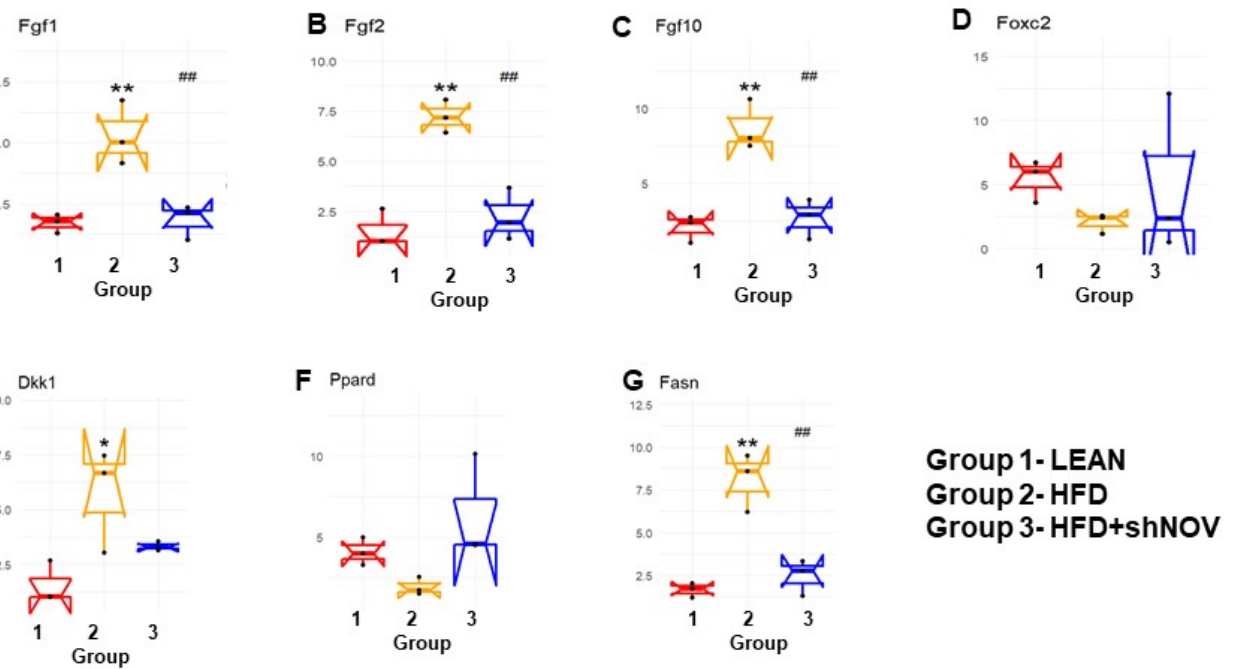
Figure 11. Changes in gene expression in the adipose tissue of shNOV-treated mice (NOV knock- down). RNA-array-analyses changes in the correlation coefficients of gene expression in lean, HFD, and Lnv-adipo-shNOV (HFD) groups. Shown are the mRNA expression (PCR array) Fibroblast growth factors (FGF) 1 ( A ), FGF 2 ( B ), FGF 10 ( C ), Forkhead transcription factor C (FOXC2) ( D ), Dickkopf-related protein 1 (DKK1) ( E ), Peroxisome Proliferator-Activated Receptor Delta (PPARD) ( F ), and fatty acid synthase (FASN) ( G ) in the adipose tissue of lean, high-fat diet (HFD), and HFD+shNOV mice. Data are expressed as means ± SE; ( n = 5); * p < 0.05, ** p < 0.005 versus lean; ## p < 0.005 versus HFD.